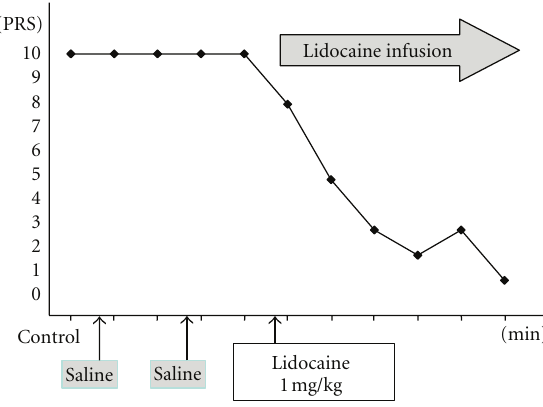
Figure 10: Drug challenge test